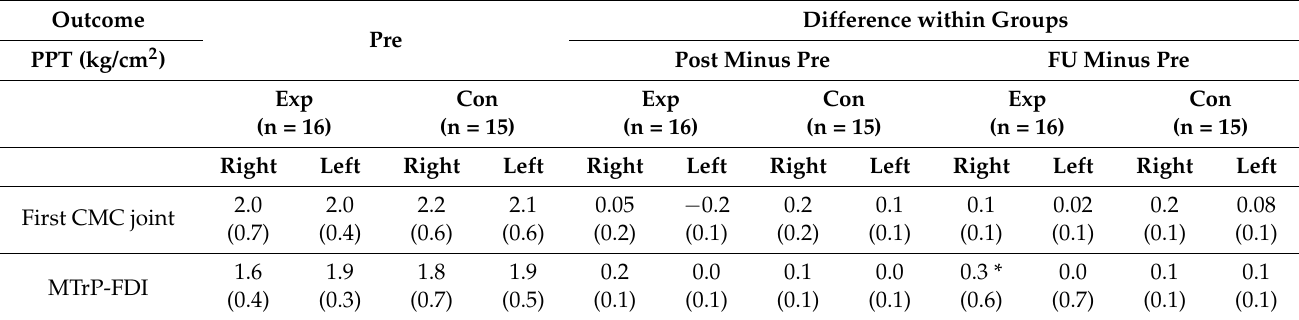
Table 2. Mean (SD) for pressure pain thresholds at all study visits for each group; mean (SD) difference within groups. Outcome